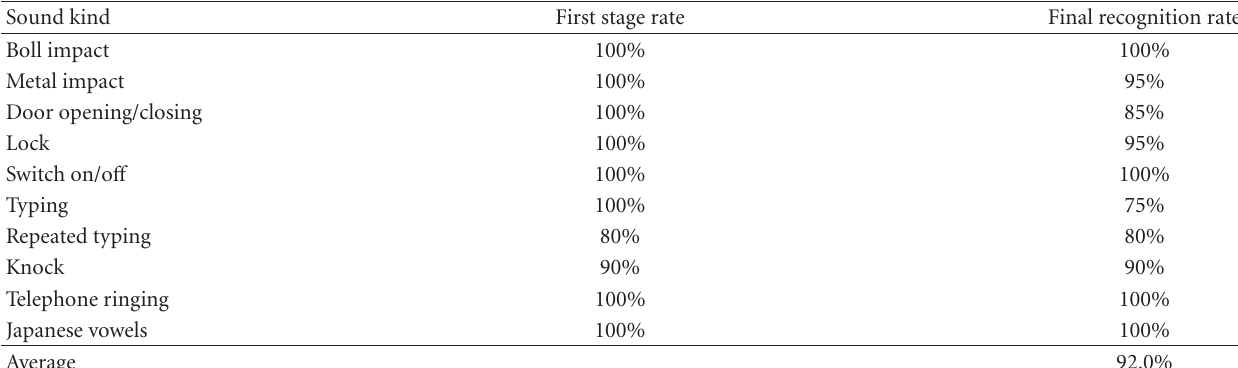
Table 3: Results of recognition experiments for environmental sounds in the original database.